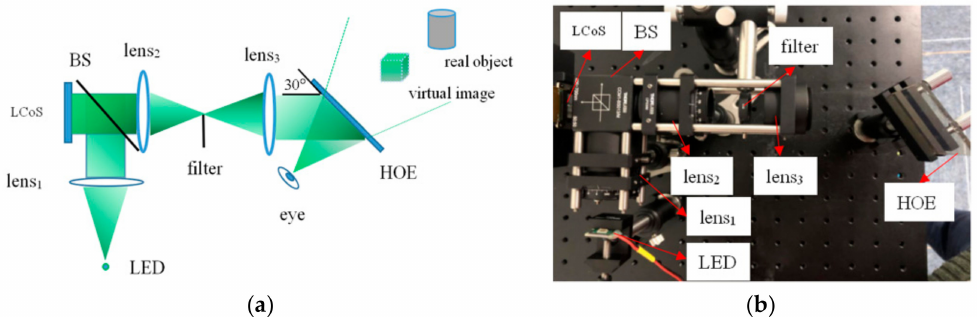
Figure 10. Holographic Augmented Reality (AR) 3D display system. ( a ) Schematic of display system; ( b ) Optical display